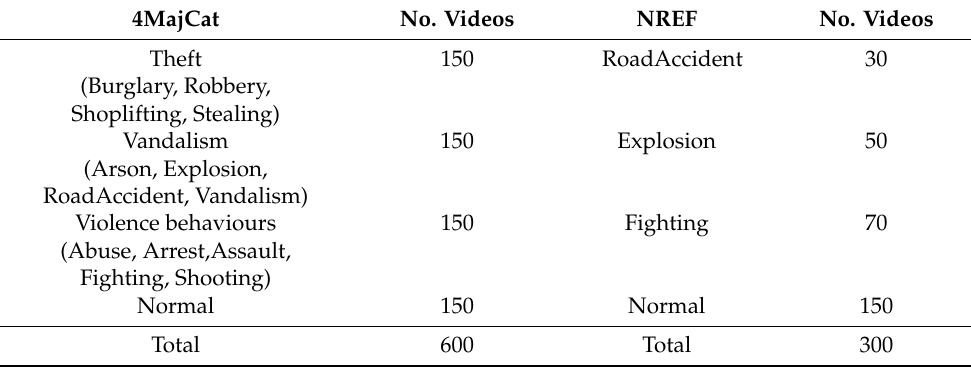
Table 2. Number of videos for 4MajCat and NREF